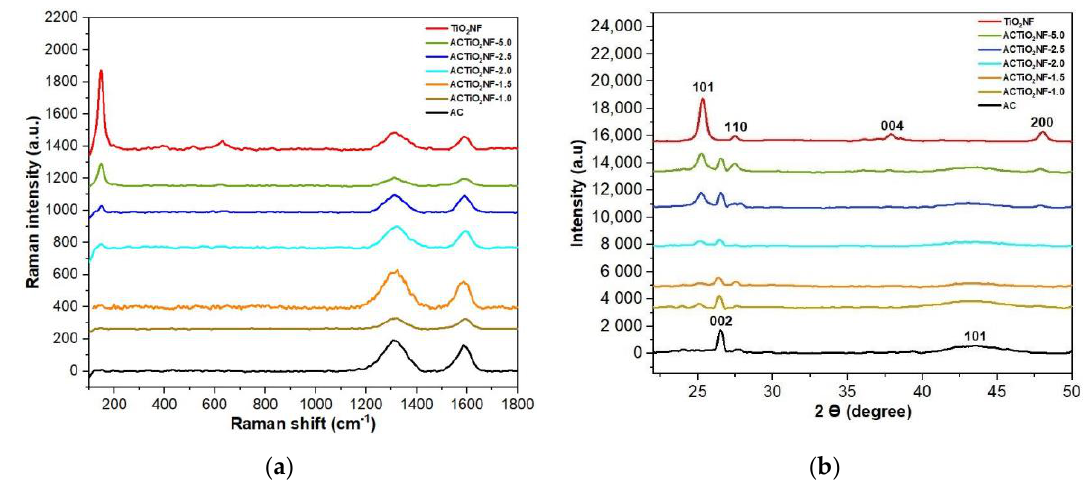
Figure 4. ( a ) Raman spectra of Titanium oxide nanofibers TiO 2 NF, pristine AC, and its composites (ACTiO 2 NF–x) and ( b ) diffractograms of titanium oxide nanofibers (TiO 2 NF), pristine AC and its composites (ACTiO 2 NF – x where x = 0.5, 1.0, 1.5, 2.0, 2.5, and 5.0 wt.% TiO 2 NF).